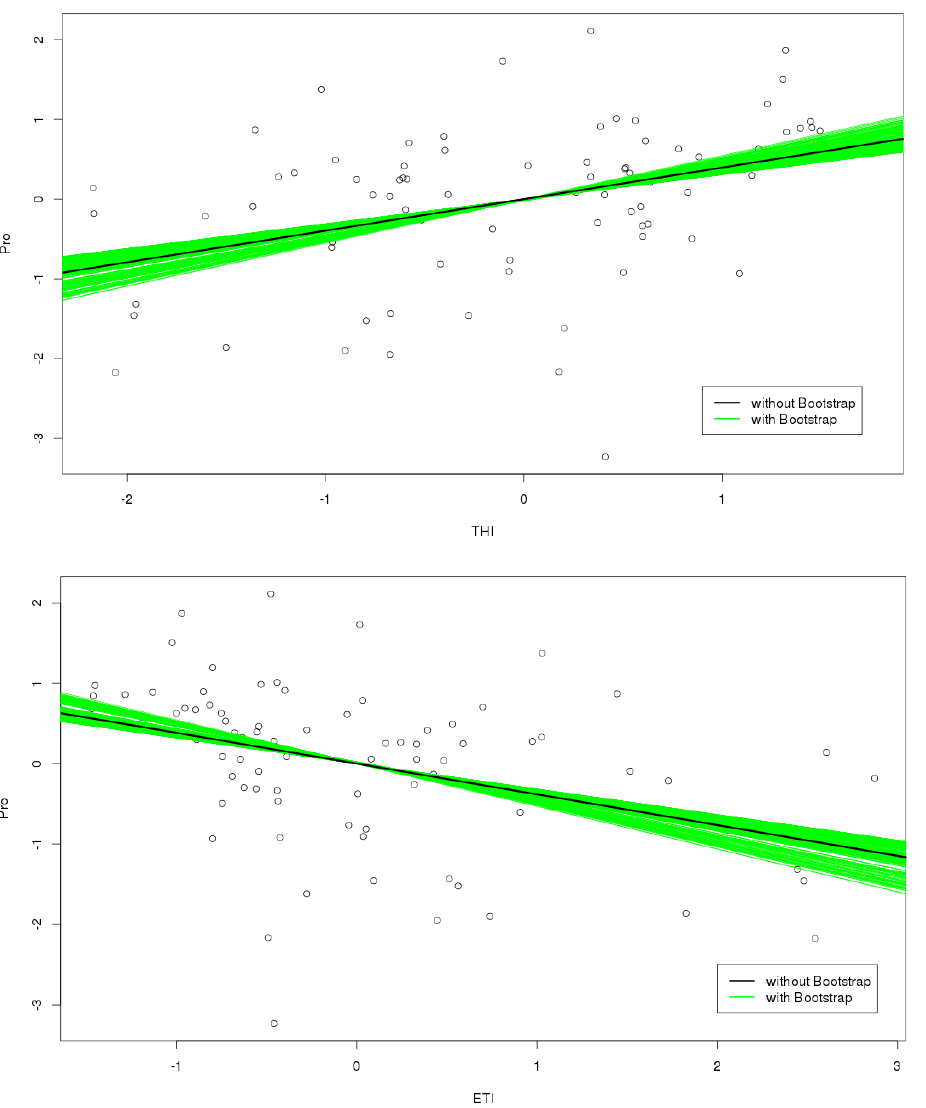
Figure 7. The best-fitted regression line before (black line) and after 1000 bootstrapping (green lines) between protein and T2M, THI and ETI indexes in